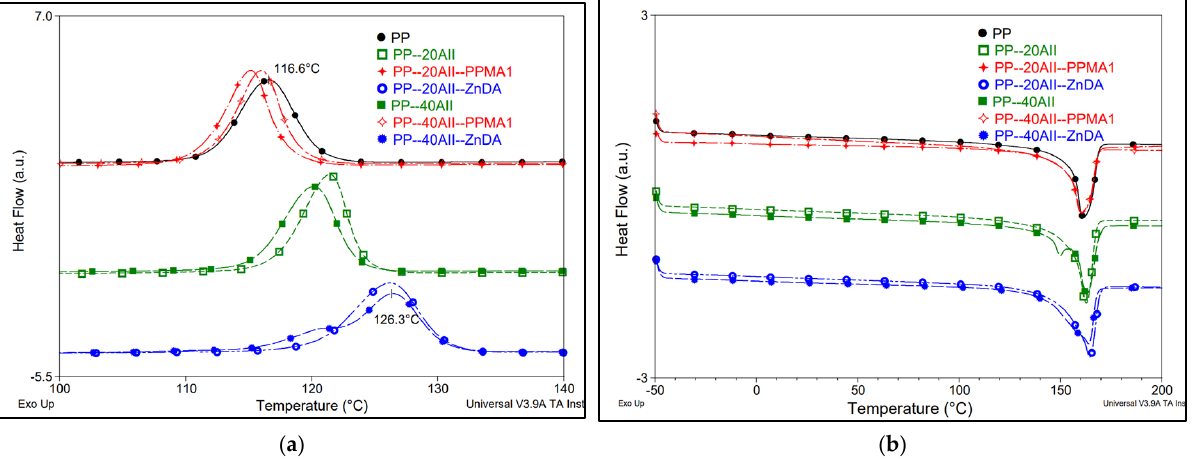
Figure 6. ( a , b ) Comparative DSC curves of neat PP and PP – (20 – 40%)AII composites (with/without modifiers) obtained during ( a ) DSC cooling and ( b ) second DSC heating (rate of 10 °C/min).